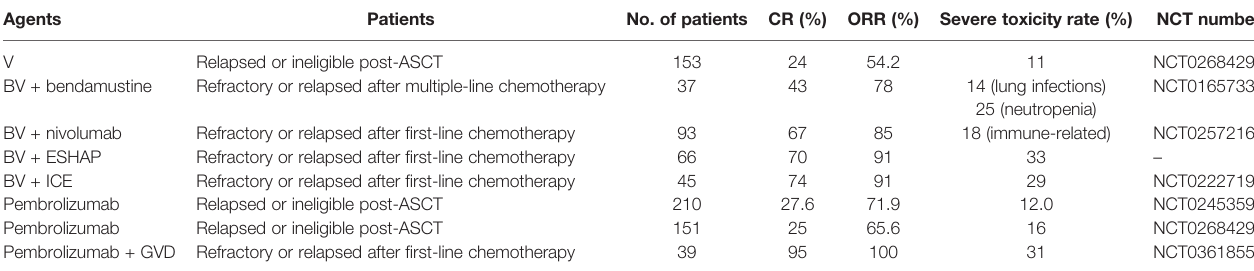
TABLE 1 | Newly reported clinical trials of salvage treatment of r/r cHL.